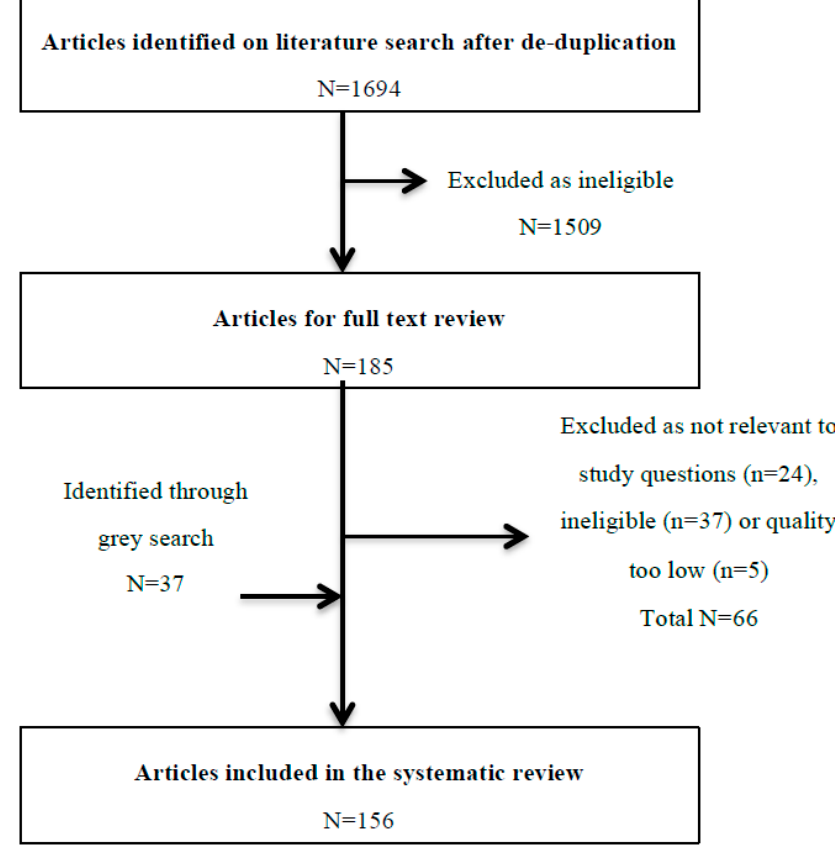
Figure 2. Flow diagram of the review process from abstract review to final inclusion. In total, these 156 articles report approximately 6200 patients with confirmed or suspected DIILD, which was fatal in around 672/2647 (25.4%) cases.